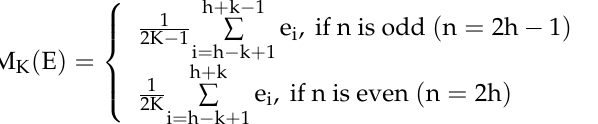
Figure 10. Algorithm flowchart. 4. Results and Discussion